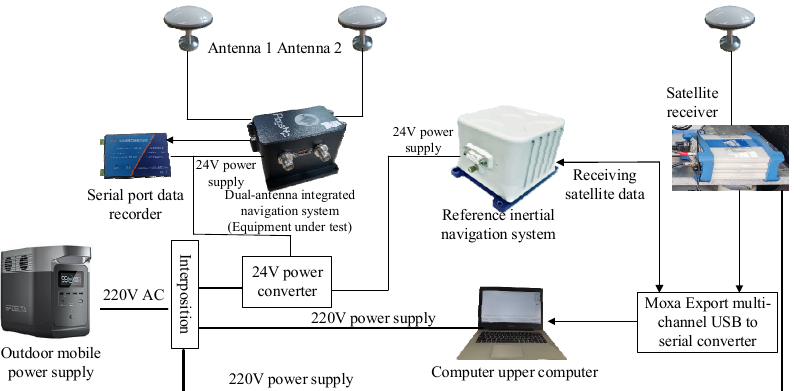
Figure 5. Installation diagram of experimental system.